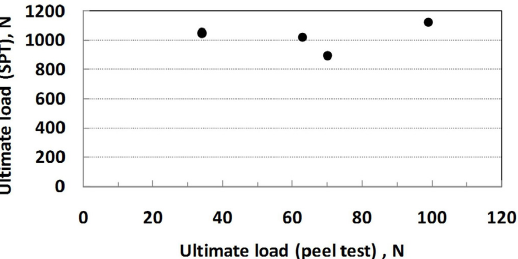
Figure 10. Peeled surface in AL/PU/perforated CU/PU/AL sandwich composite.